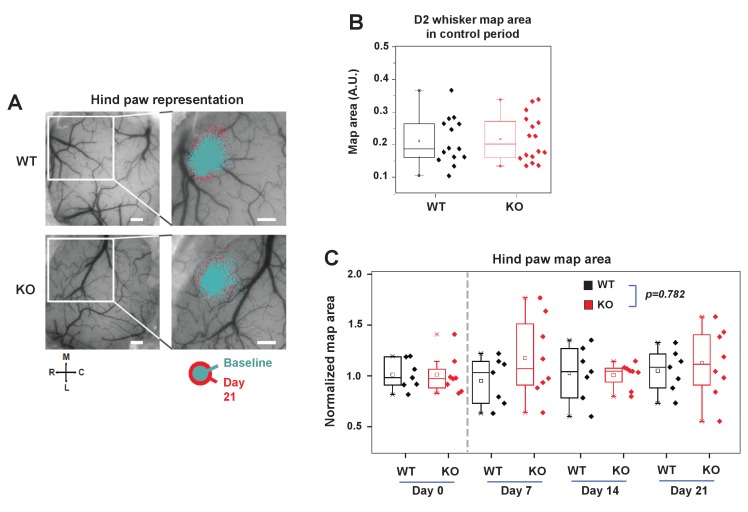
IDOL is required for experience-dependent neural plasticity.(A) Box-plot graph showing sensory map size of D2W at baseline in WT (n = 7) and IDOL-deficient (n = 8) mice. Baseline OIS imaging was acquired in 2 separate sessions (1 week apart) and averaged. (B) Functional representation of the contralateral hindpaw (HP) before and after sensory deprivation. OIS response maps were overlaid on a photograph of the surface vasculature (left panels) to create regional maps of HP activation (right panels). White square indicates field of view in right images in WT (top) and IDOL-deficient (bottom) in control (cyan) and 21 days after whisker removal (red) except one (the spared whisker – D2). Scale bar: 0.5 mm. Orientation: M – medial, L – lateral, R – rostral, C – caudal. (C) Comparison of normalized HP functional representation map size in WT (black) and knockout (red) mice over time. WT (n = 7) and knockout (n = 8). The HP maps remained relatively stable over time. There is no significant difference between WT knockout groups with time as a factor (Two-way ANOVA with repeated measures, interaction between genotype and time; p=0.78193).